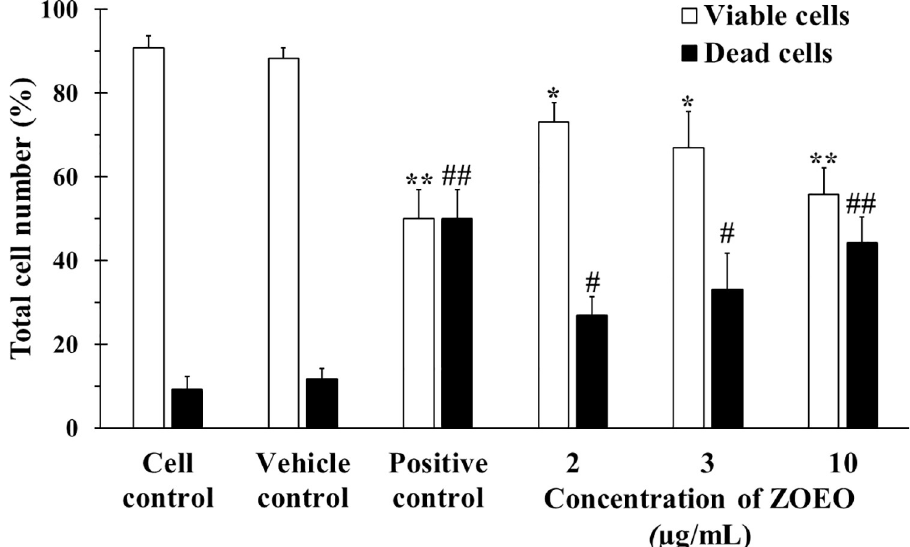
Fig 2. Total number of viable and dead MCF-7 cells after 48 h in cell control (CC), vehicle control (VC), and various concentrations of ZOEO, in comparison with the positive control (cytarabine at 2 μ g/mL). Each bar represents mean ± SD of three independent experiments performed in triplicate. Asterisk ( � ) denotes significant differences from viable cells in vehicle control; �� p < 0.001. Sharp (#) denotes significant differences from dead cells in vehicle control; ## p < 0.001. The dataset is available in S5 Table.